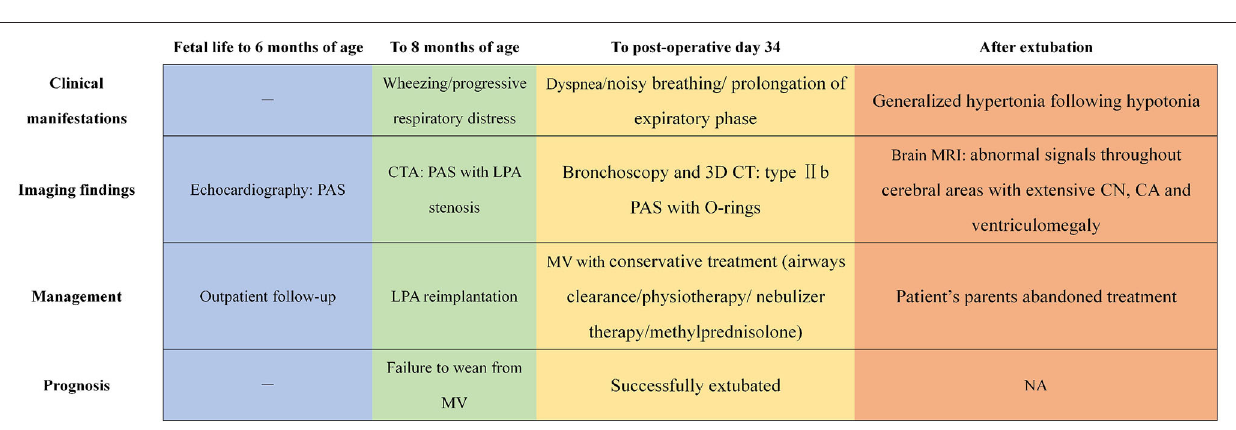
FIGURE 3 | The timeline showcasing relevant data from the episode of care. PAS, pulmonary artery sling; CTA, computed tomography angiography; LPA, left pulmonary artery; MV, mechanical ventilation; 3D, three-dimensional; CN, cortical necrosis; CA, cerebrum atrophy; NA, not